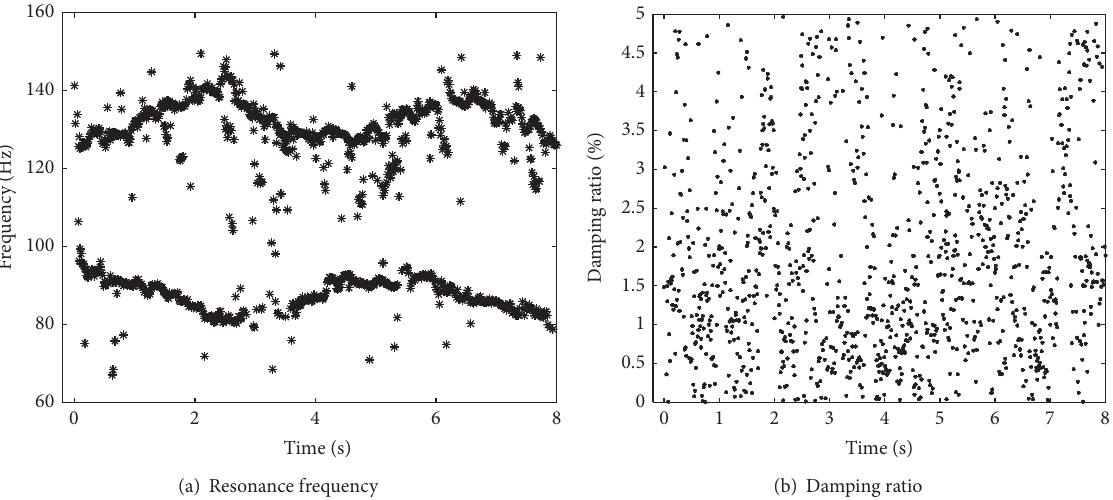
Figure 8: Estimated modal frequency and damping